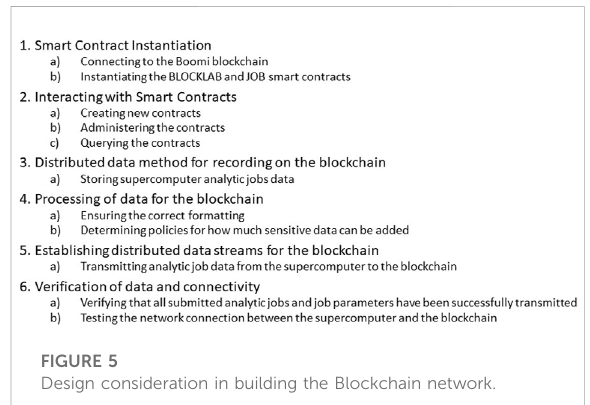
FIGURE 5 Design consideration in building the Blockchain